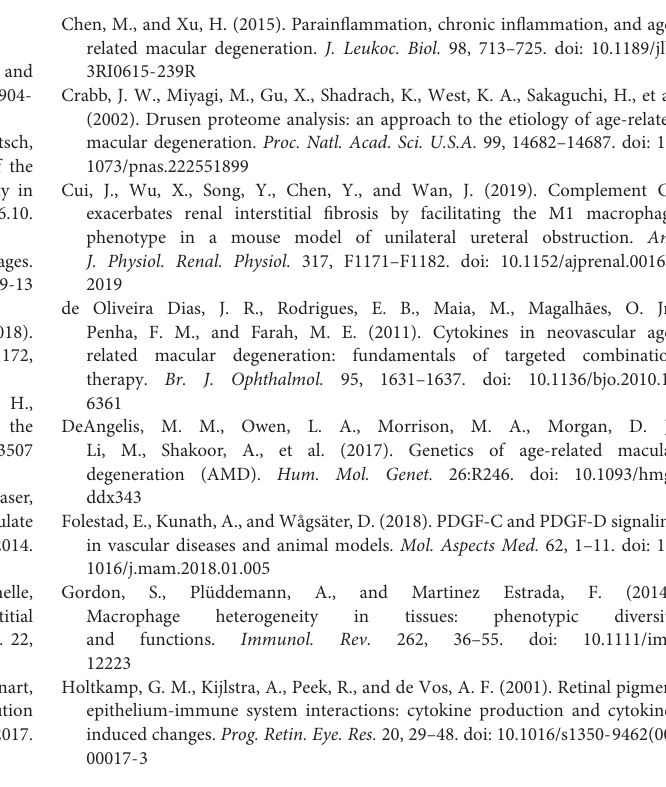
expression in normal mouse retinae and choroids. Scale bar: 50 µ m. n = 5, * p < 0.05, ** p < 0.01, ns, not significant. Supplementary Figure 4 | RNA-seq and transcriptomic analysis showing PDGF-D induced. complement pathway, chemokine and cytokine signaling, extracellular matrix and growth factors. (A,B) Real-time PCR results showing PDGF-D-induced upregulation of complement pathway genes (A) and chemokine and their receptors (B) in mouse RPE-choroids. (C,D) Heatmaps of PDGF-D-induced DEGs associated to cytokine family (C) and extracellular matrix (ECM) and growth factors (D) n mouse RPE-choroids. (E,F) Real-time PCR results showing PDGF-D-induced upregulation of Il7r (E) and extracellular matrix genes (F) . n = 5, * p < 0.05, *** p < 0.001, **** p < 0.0001. Supplementary Figure 5 | PDGF-D promotes mouse choroid sprouting in a dose-dependent manner. (A) PDGF-D protein treatment induced mouse choroidal sprouting. (B) Quantifications of the choroidal sprouting in (A) . n = 5, ** p < 0.01, *** p < 0.001, **** p < 0.0001, ns: not significant. Supplementary Figure 6 | SB290157 inhibits PDGF-D-induced macrophage migration and gene expression. (A) SB290157 inhibited mouse (upper penal) and human (lower panel) macrophage migration induced by conditioned medium from PDGF-D-treated HRPE cells (PDGF-D-CM). (B,C) Real-time PCR results showing that SB290157 inhibited AAV-PDGF-D-induced upregulation of M1 and M2 macrophage polarization genes (B) and cytokine and chemokine genes (C) . Scale bar: 500 µ m. All the experiments were performed in triplicates, ** p < 0.01, *** p < 0.001, **** p < 0.0001. Supplementary Figure 7 | Vascular changes in the flat-mounted retinas with PDGF-D overexpression with or without SB290157 treatment. (A) Analysis of flat-mounted retinas after IB4 staining (green) showing that PDGF-D overexpression increased retinal vascular branch points, which was abolished by SB290157 treatment. (B) Quantifications of vascular branch points in the mouse retinas with PDGF-D overexpression with or without SB290157 treatment. Scale bars in (A) : upper panel 500 µ m, lower panel 50 µ m, n = 8, *** p <